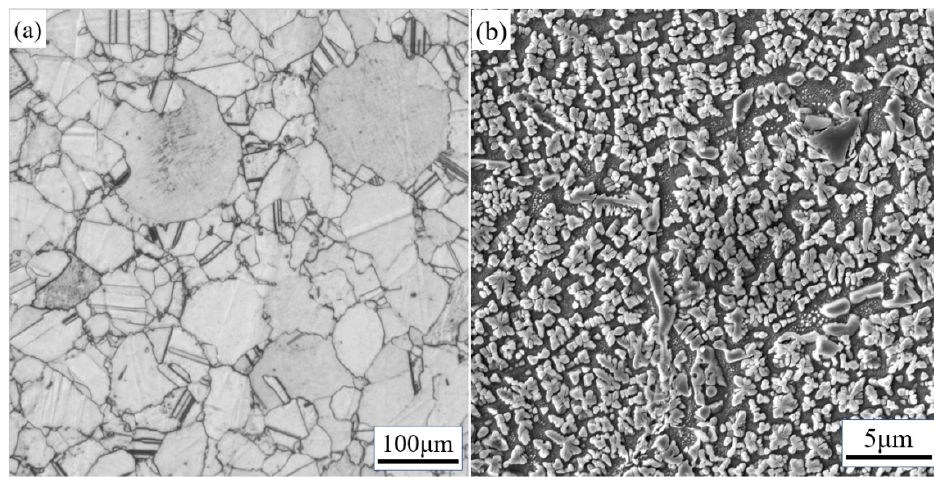
Figure 1. Initial microstructure of the as-HIPed FGH4096: ( a ) grain structure and ( b ) γ′ precipitates morphology.